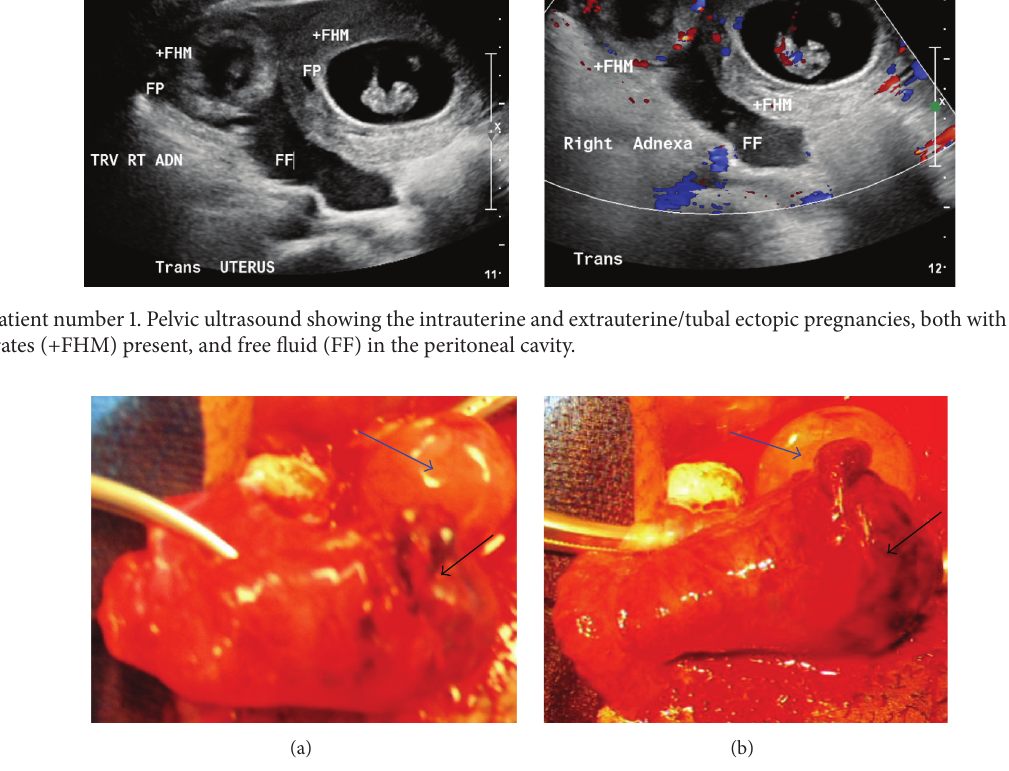
Figure 2: Patient number 1. Operative finding showing a ruptured right ectopic pregnancy (black arrow) with an ovarian corpus luteal cyst (blue